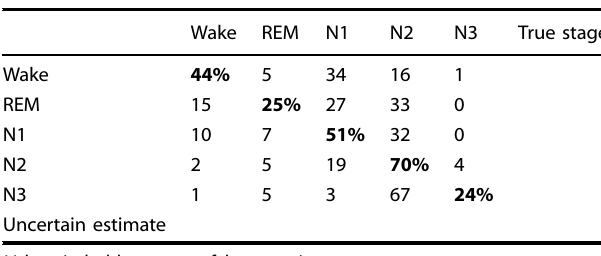
Fig. 3 Generation of hypnogram with underlying uncertainty. a Automated hypnogram estimate for an HN subject. b Probabilities determining the estimated sleep stages. c Raw algorithm uncertainty values before thresholding. S threshold pertains to the Shannon entropy cutoff (1 bit). Table 2. Certain sleep stage classi fi cation confusion matrix. Table 3. Uncertain sleep stage classi fi cation confusion